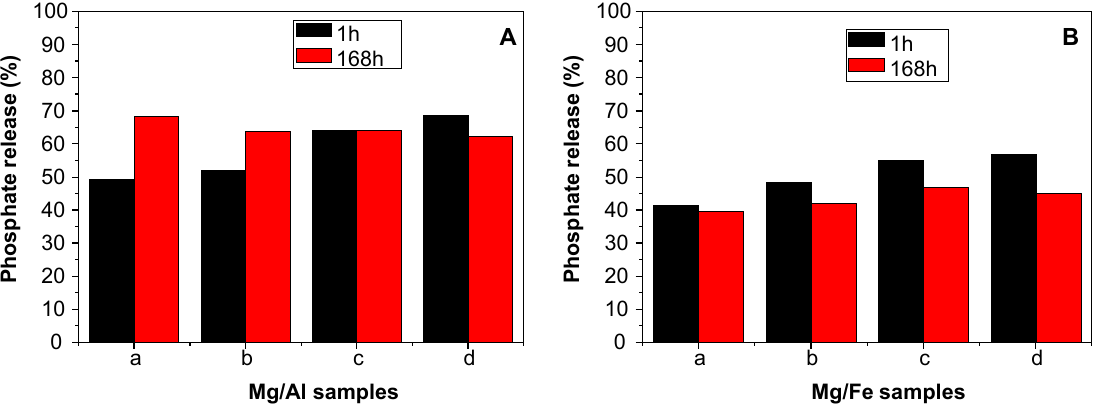
Figure 3. Phosphate release essays at 1 hour and 168 hours for MgAl/K 2 HPO 4 ( A ); and MgFe/K 2 HPO 4 ( B ) systems, with LDH calcined at: 200 °C (a), 300 °C (b), 400 °C (c) and 500 °C (d).